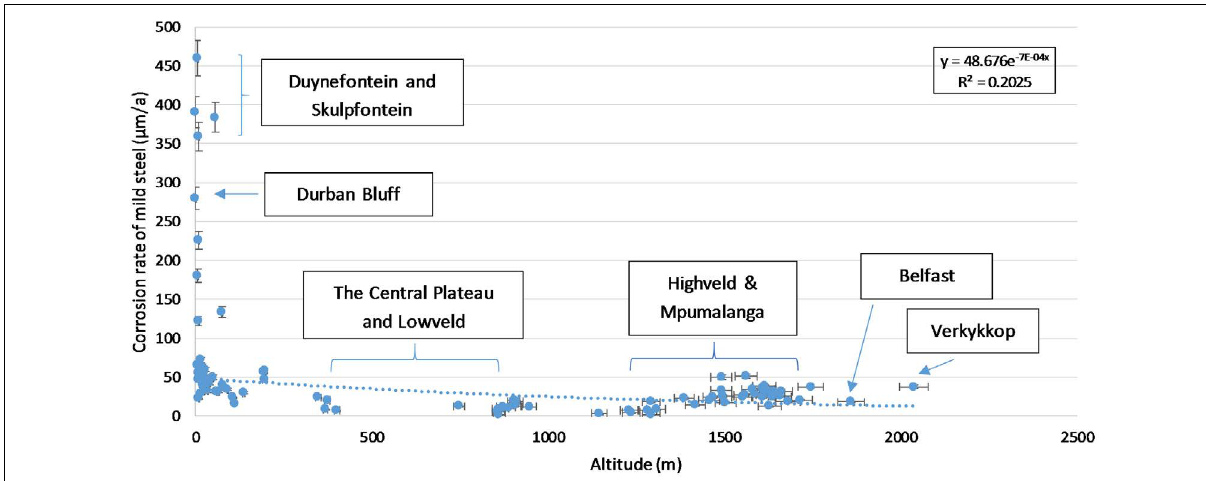
Figure 5: First-year (12-month) corrosion rates of mild steel, measured at numerous sites in South Africa, versus the relative altitudes (elevations above sea level) of the sites.